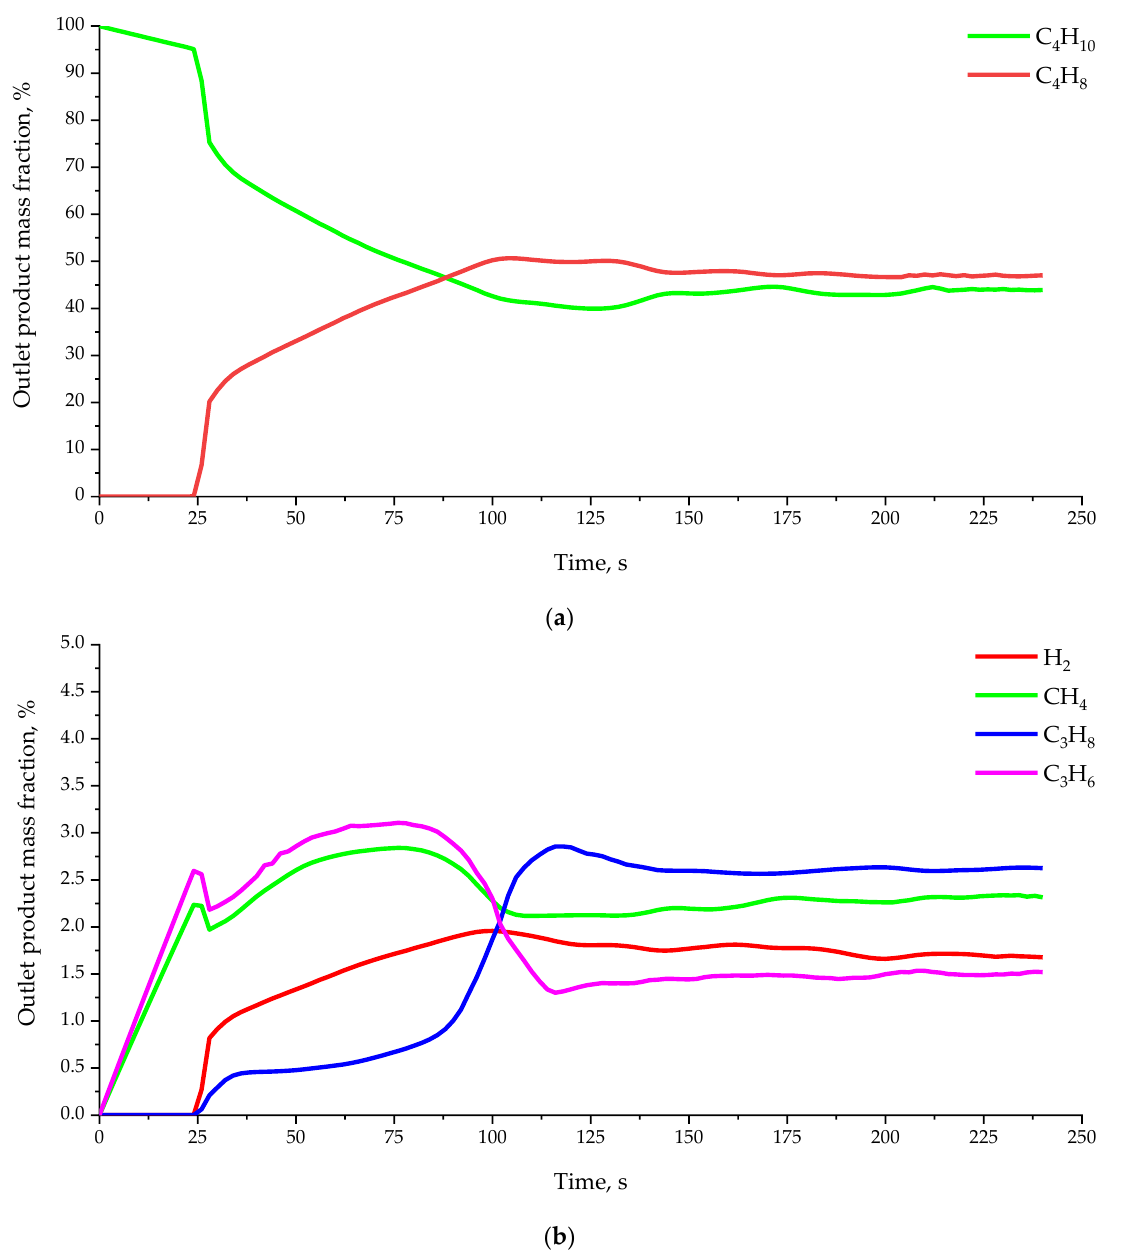
Figure 4. The mass fraction of reaction products for the case of catalyst mass of 100 g, a gas velocity of 0.016 m/s, and temperature of 575 °C: ( a ) C 4 H 10 and C 4 H 8 ; ( b ) H 2 , CH 4 , C 4 H 8 and C 4 H 6 .